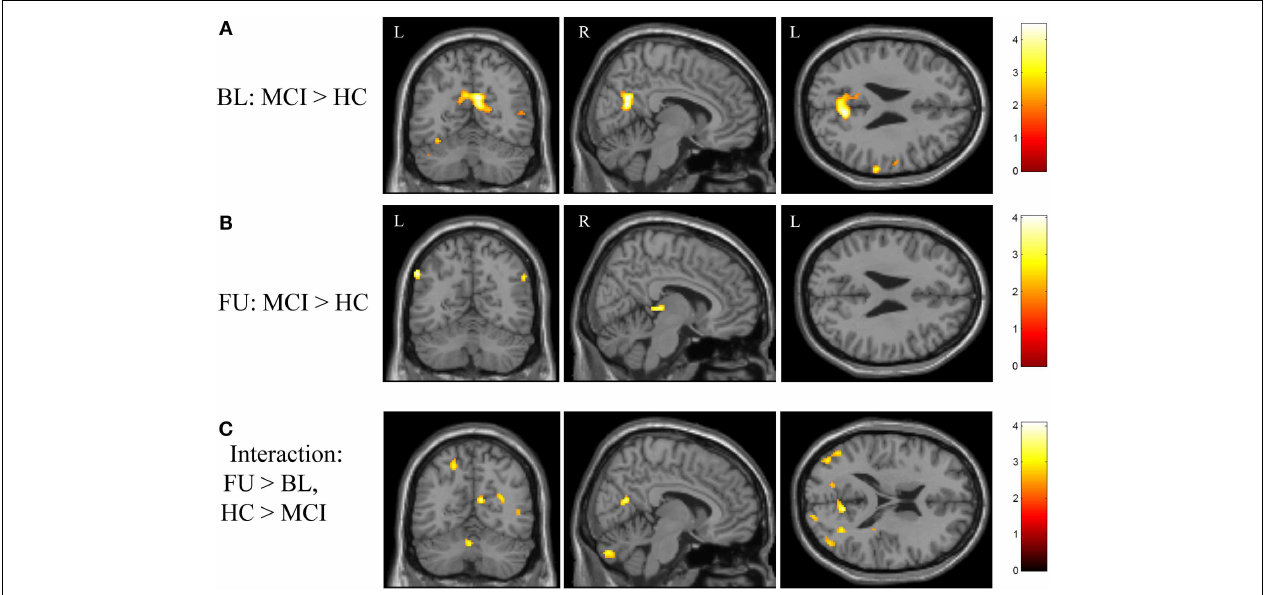
displayed at a voxel-wise threshold of p < 0.01 (uncorrected) and a minimum cluster size ( k ) = 50 voxels. However, all observed clusters include local maxima that meet a voxel-wise threshold of p < 0.001 (uncorrected; see TableA2 in Appendix). Further, the medial parietal lobe cluster observed in (A) is significant at a cluster-wise threshold of p < 0.05 (family-wise error correction for multiple comparisons). See the “Results” section and TableA2 in Appendix for additional results. FU = follow-up, BL = baseline, MCI = mild cognitive impairment, HC = healthy older adults, R = right, L =